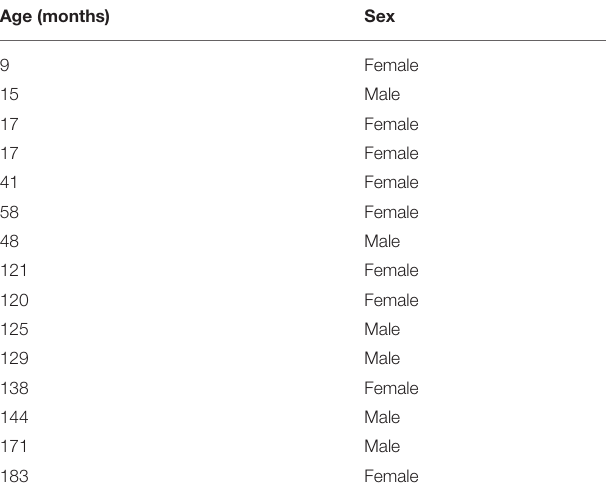
TABLE 2 | Border collie dogs included in study